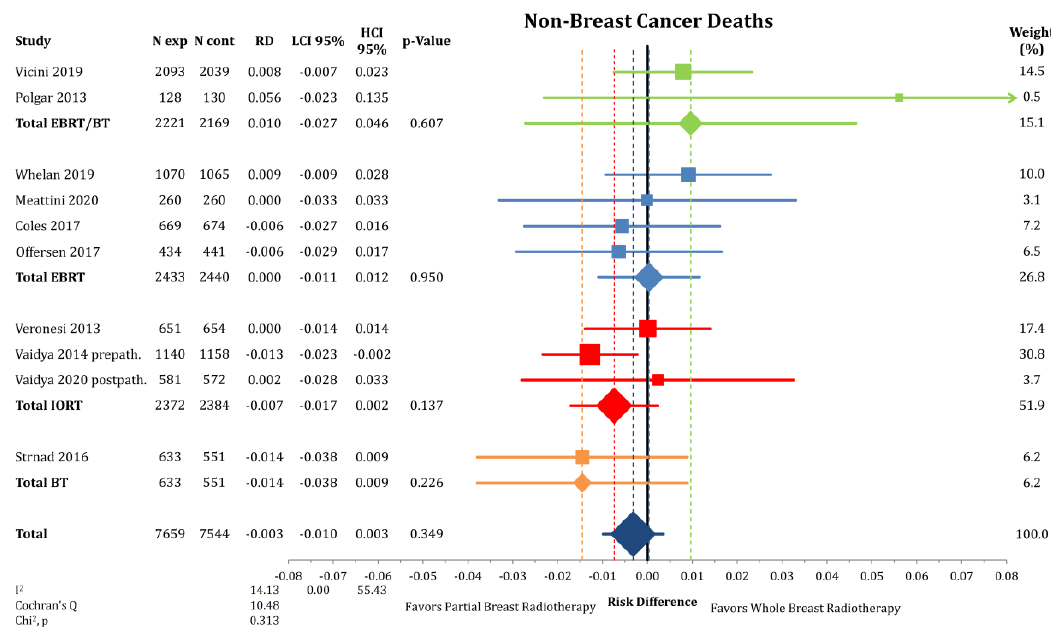
Figure 5. Comparison of non-breast cancer death by risk difference between partial- and whole breast radiation by a forest plot. Trials are grouped by radiation technique. Quadrats and diamonds represent individual trials and pooled effect sizes with corresponding 95% confidence intervals.